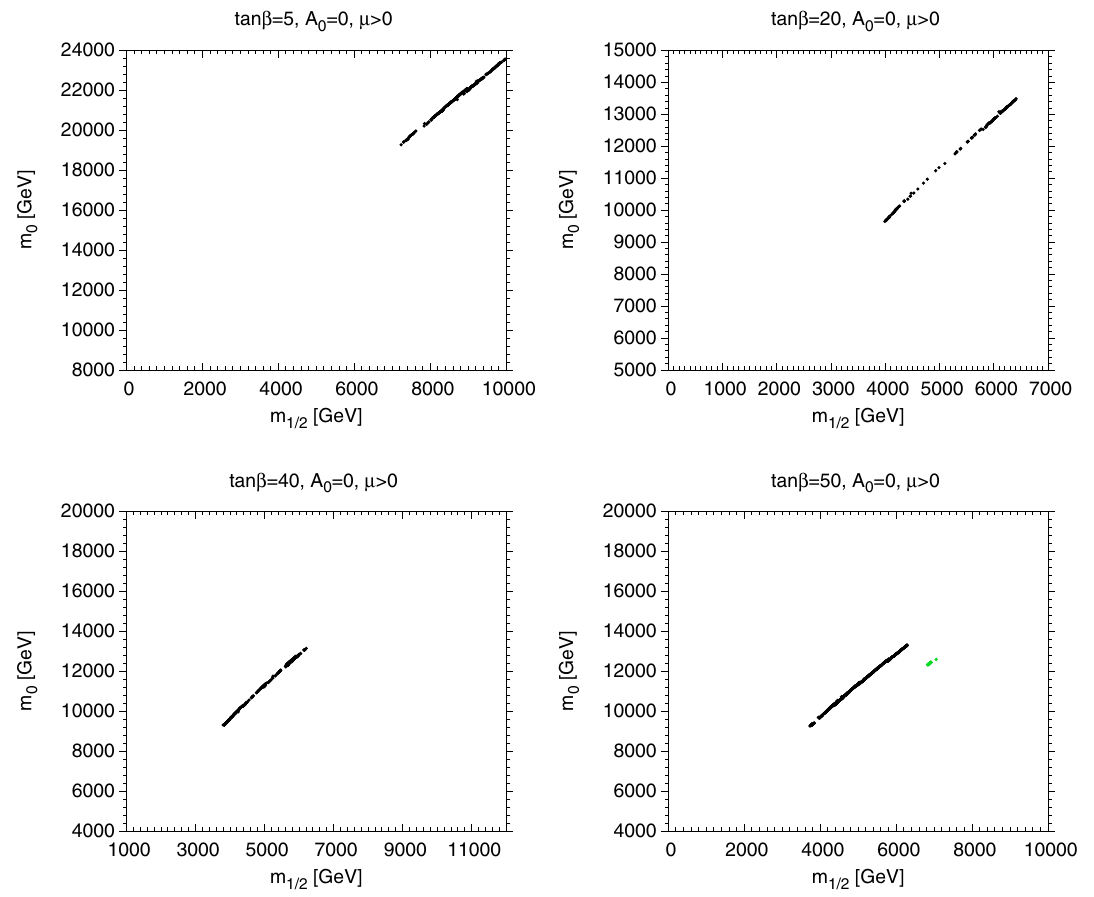
Fig. 14 The portions of the dark matter strips for tan β = 5 , 20 , 40 and 50, calculated assuming A 0 = 0 and μ > 0, that are allowed by all the constraints, assuming an uncertainty of 1 . 5 GeV in the calculation of m h . There are no allowed regions for tan β = 55 or